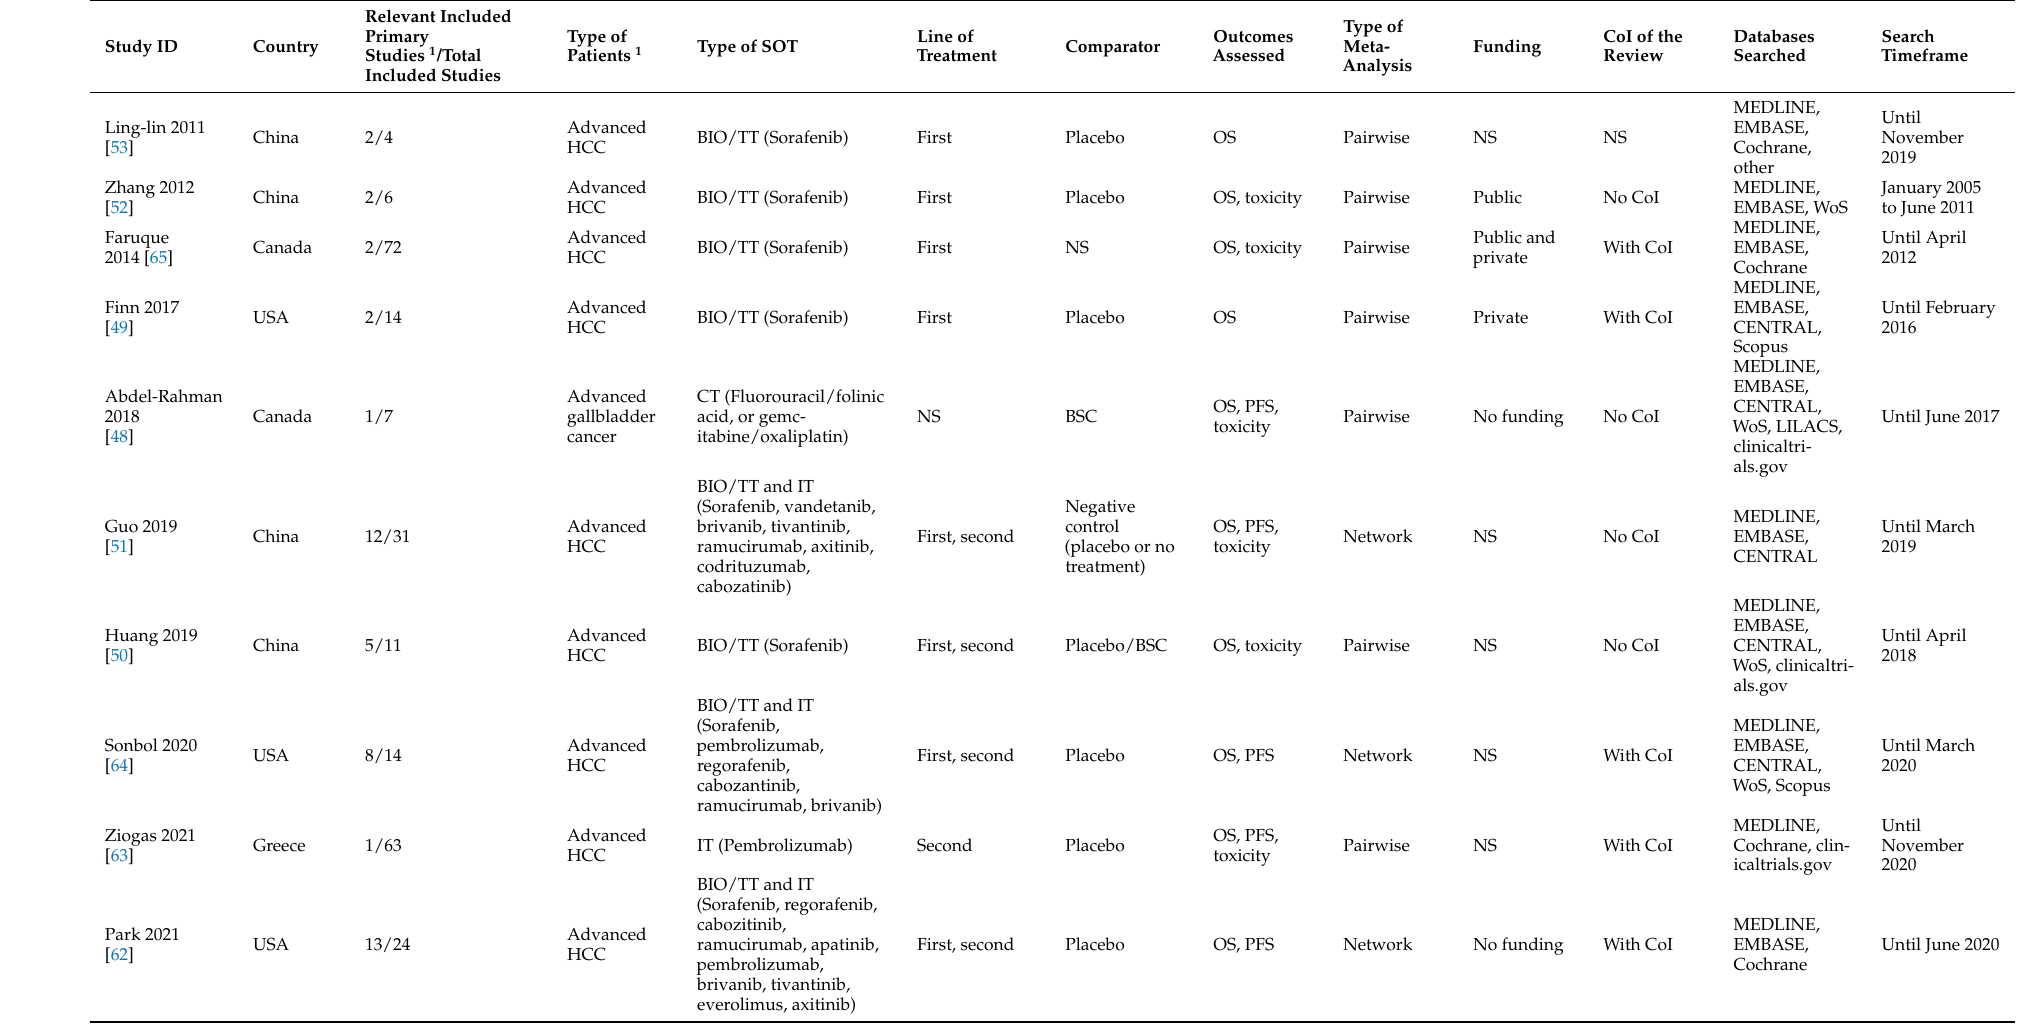
Table 1. Description of the included